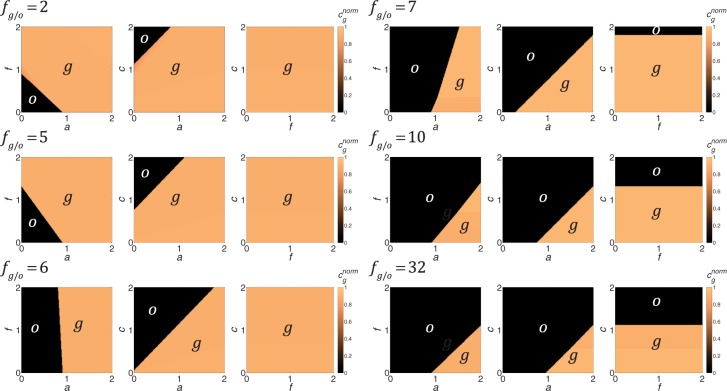
Optimal ATP production mode for peak-demand.The effects of the costs of excess ATP, a, glycolytic capacity, c, glucose, f, and the production efficiency ratio, fg/o, on whether it is optimal for the cell to use oxidative phosphorylation (o) or glycolysis (g) to meet peak ATP demand. As cost parameters change, there are abrupt shifts from one metabolic strategy to the other. The lines separating regions of oxidative versus glycolytic metabolism are called “isolegs” and their slopes and intercepts indicate how the cost parameters interact. Increasing the production efficiency ratio, fg/o, decreases the region over which glycolysis is optimal. Decreasing a or c generally favors glycolysis. The effect of f on the optimal metabolism for meeting peak demand depends on the relative glucose efficiency of oxidation versus glycolysis, fg/o. The values for all other parameters are the same as those in Fig 2.